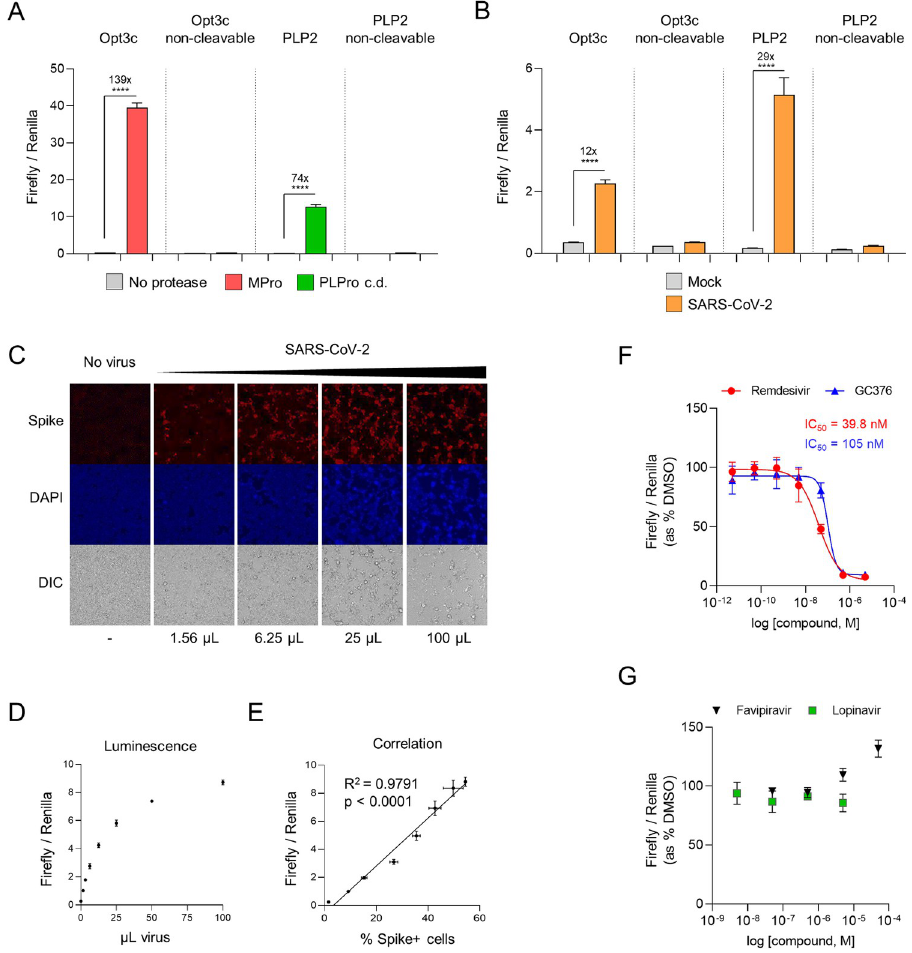
Fig 3. Luminescent biosensors of authentic SARS-CoV-2 infection. ( A ) Activation of luciferase-based reporters by recombinant SARS-CoV-2 protease expression. HEK293T cells were co-transfected with indicated 30F biosensors ± MPro, PLPro c.d., or empty pcDNA3.1. ( B ) Activation of luciferase-based reporters by SARS-CoV-2 infection. HEK293T-ACE2 cells were transfected with indicated 30F biosensors, incubated for 12 h, then mock- infected or infected with SARS-CoV-2 at MOI = 0.01. ( C-E ) Quantitation of infected cells. HEK293T-ACE2 cells were transfected with the 30F-PLP2 biosensor, incubated for 12 h, then mock-infected or infected with increasing doses of SARS-CoV-2. 1 μ L of viral stock corresponds to MOI � 0.01. Cells were analysed in parallel 24 h post-infection by either epifluorescence microscopy for SARS-CoV-2 spike protein ( C ), or luminometry for Firefly and Renilla luciferase activities ( D ). Spike+ cells were enumerated by automated microscopy (Cellomics). Illustrative microscopy data ( C ) and mean values ± SEM ( D ) are shown for an experiment performed in duplicate (microscopy) or triplicate (luminometry). The correlation between the ratio of Firefly/Renilla luminescence and the proportions of spike+ cells is shown in E . Spike, red. DAPI, blue. DIC, differential interference contrast. R 2 , Pearson’s correlation coefficient. Representative of 2 independent experiments. ( F-G ) Inhibition of SARS-CoV-2 replication by candidate antivirals. HEK293T-ACE2 cells were transfected with the 30F-PLP2 biosensor, incubated for 12 h, then infected with SARS-CoV-2 at MOI = 0.01 in the presence of DMSO or decreasing doses of candidate antivirals. Titration curves and IC50s are shown for remdesivir and GC376. Representative of 2 independent experiments. For all experiments, Firefly and Renilla luciferase activities were measured by luminometry 24 h post-transfection ( A ) or infection ( B-G ). Unless otherwise stated, mean values ± SEM are shown for experiments performed in triplicate, representative of at least 3 independent experiments. For F-G , Firefly/Renilla luminescence is shown as % luminescence in the DMSO condition. ���� p < 0.0001. MPro, recombinant SARS-CoV-2 Main Protease. PLPro c.d., catalytic domain of recombinant SARS-CoV-2 Papain-Like